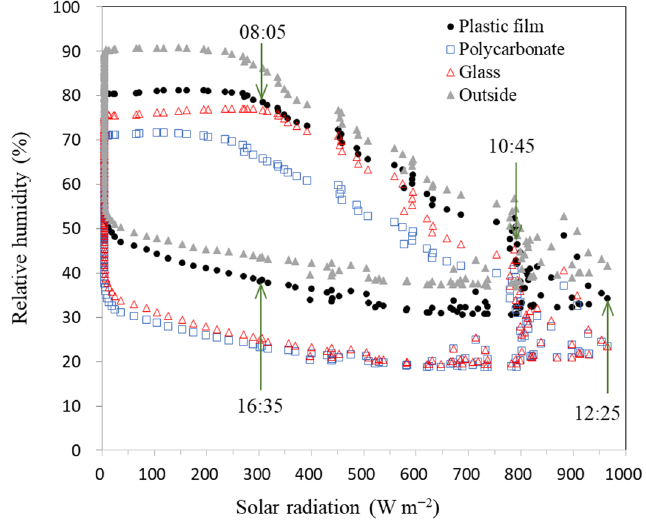
Figure 11. Comparison of relative humidity as a function of solar radiation in greenhouses covered with different covering materials (12 − 13, 19 − 20, and 26 − 27 October 2019).